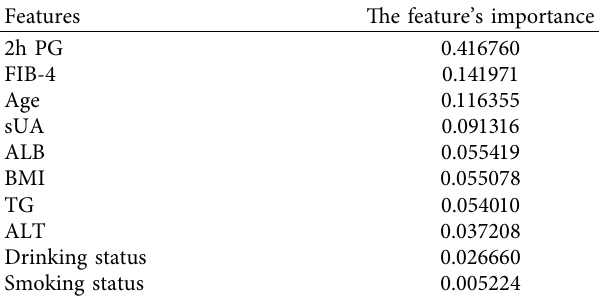
Table 5: The importance of features on